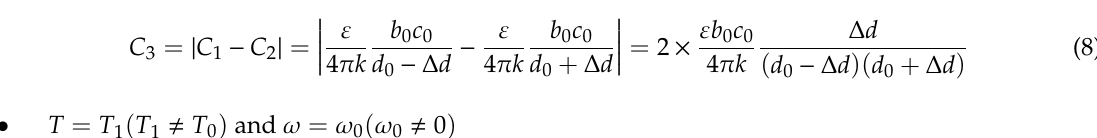
ω = ω   . ( a ) top view; ( b ) side view. Figure 4. Combs of moving plates and fixed plates when T = T T T  and 0 and 0 . ( a ) top view; ( b ) side 0 0